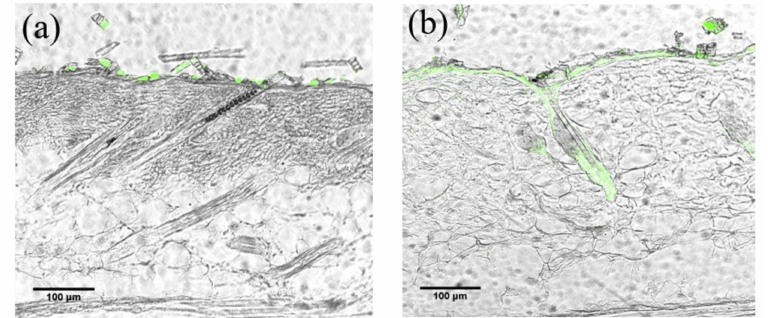
Figure 31. Fluorescence microscopy images of cross-sections of mouse skin without iontophoresis ( a ) and with iontophoresis ( b ) using fluorescein isothiocyanate-HEL-loaded nanoparticles [203]. Reproduced with permission from Elsevier